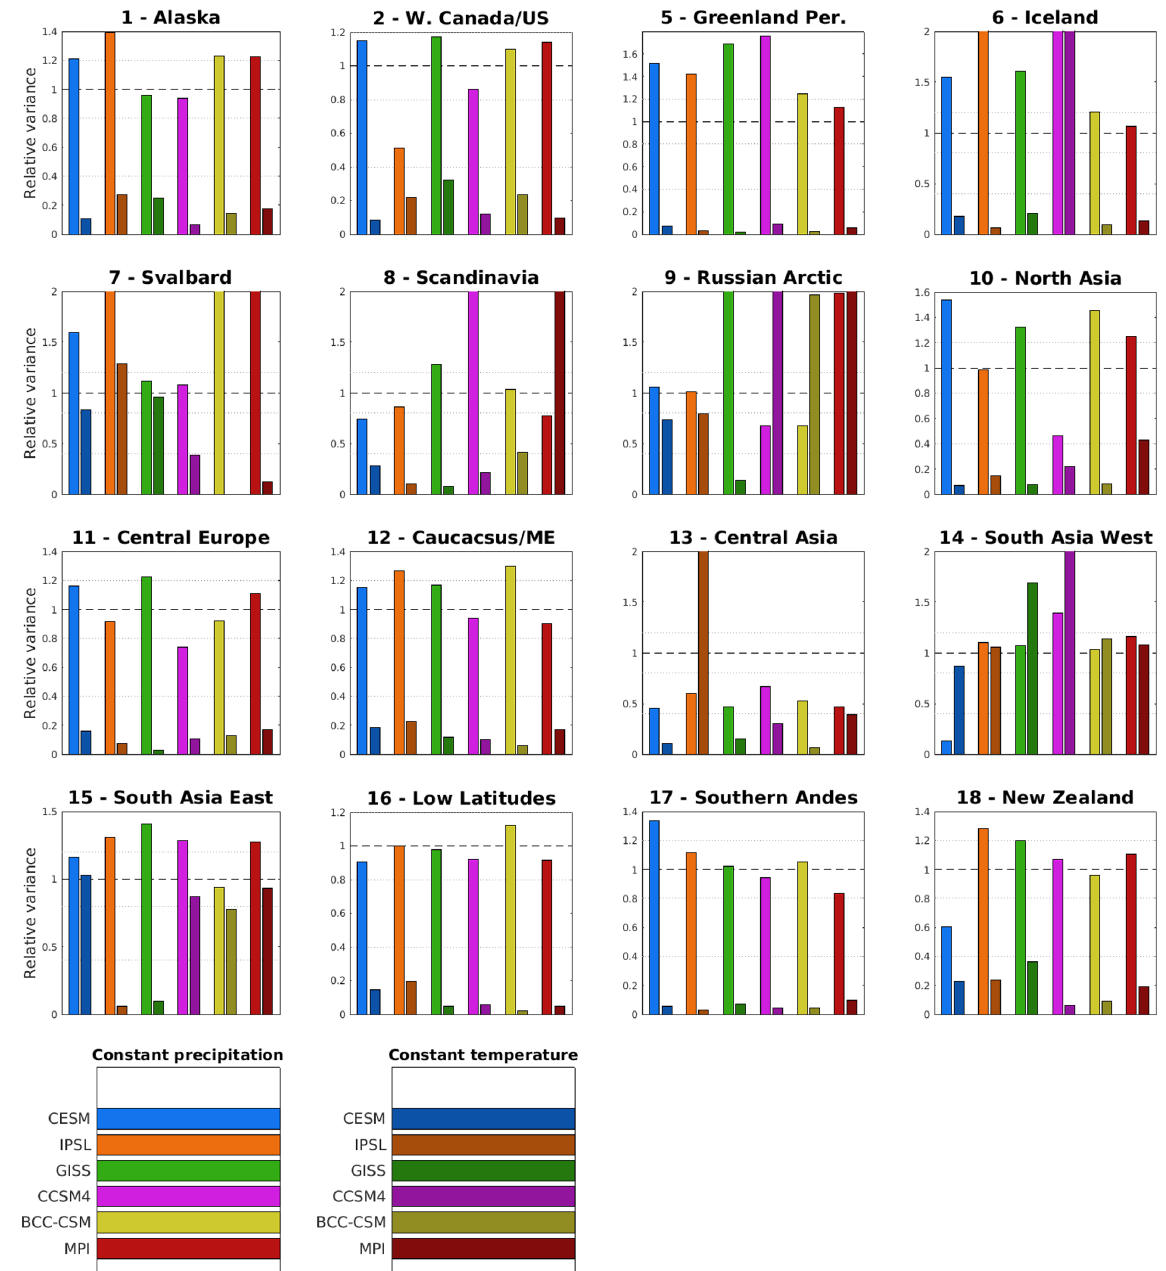
Figure 10. Relative variance of the constant precipitation and constant temperature runs to the full climate model run for each of the six climate models used. A relative variance of 1 (dashed line) indicates the same overall variance in the constant precipitation and temperature runs as in the full climate run. A low relative variance in the constant precipitation run indicates a small impact of temperature on glacier length changes and vice versa. A high relative variance in the constant precipitation run may indicate a large impact of temperature on glacier length changes (and vice versa), though in cases of relative variance greater that 1, there are several possible explanations for this behaviour. The same information is shown numerically in Tables S1–S4, sorted into categories – the borders of these categories are shown here by the dotted